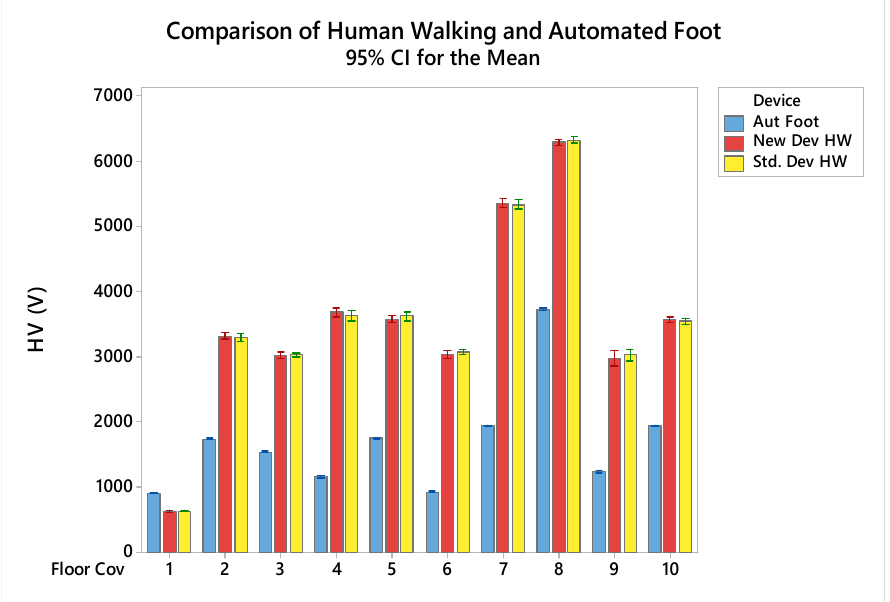
Figure 13. HV (Highest Valleys) graph that shows the comparison of automated foot device, and human walking mode devices.